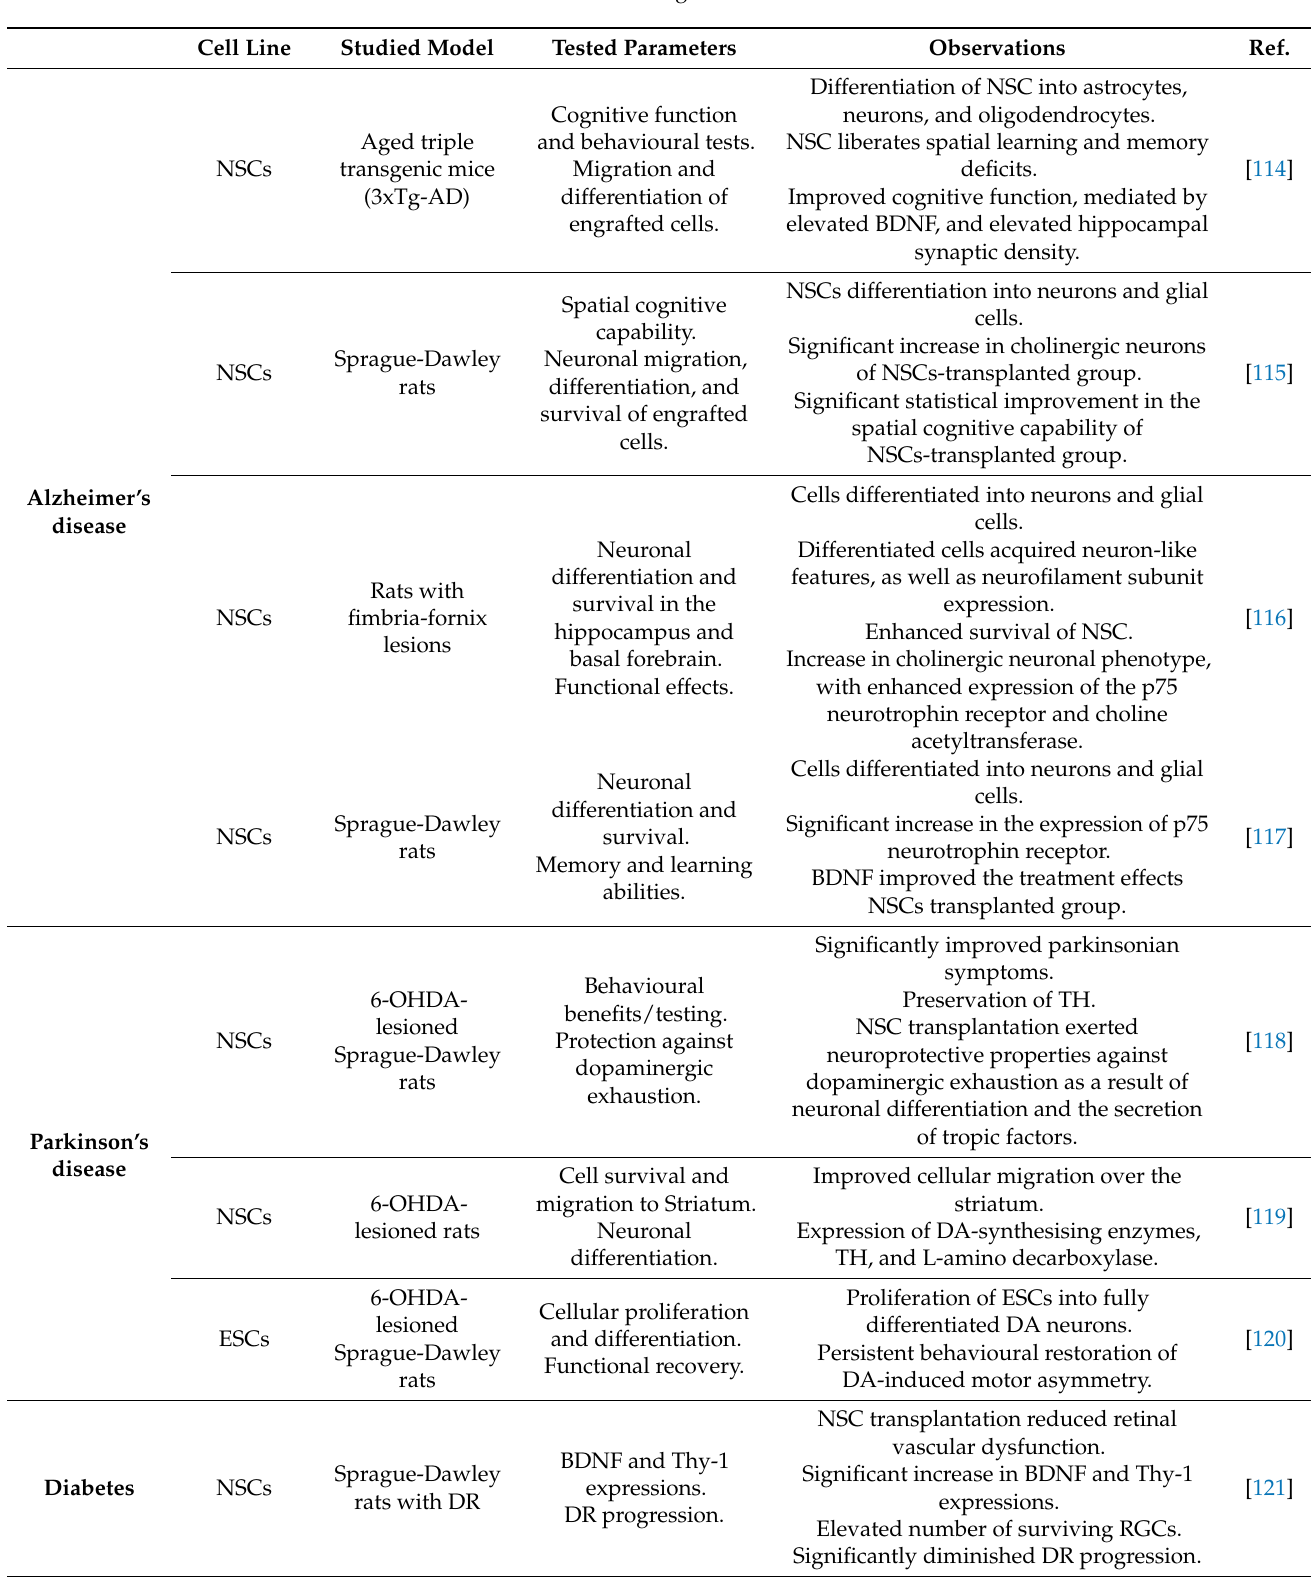
Table 1. NSC studies in chronic degenerative